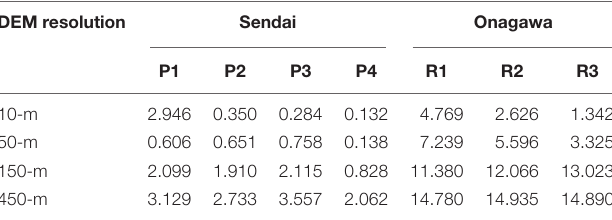
TABLE 3 | Tsunami insurance pure premium rates for wood structures using DEMs of different resolutions (per 1000 insured value). DEM resolution Sendai